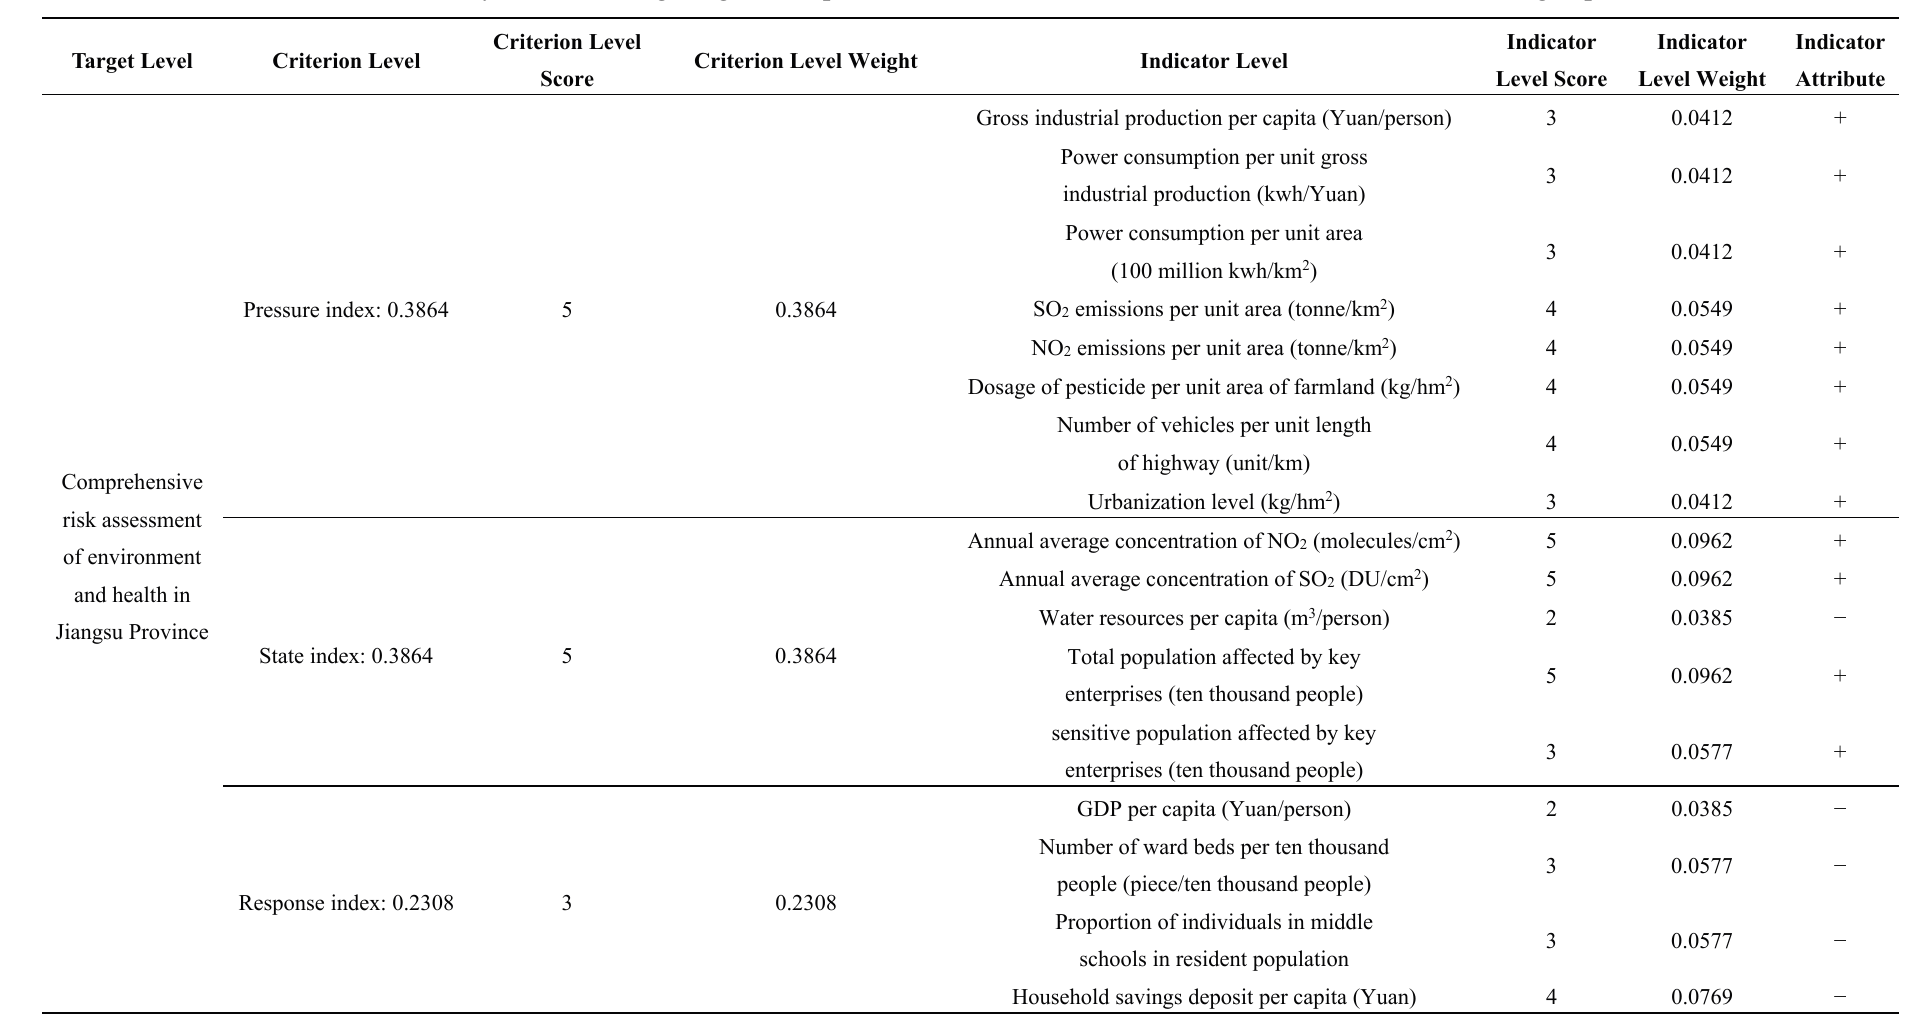
Table 1. Indicator system and weighting of comprehensive environment and health risk assessment for Jiangsu